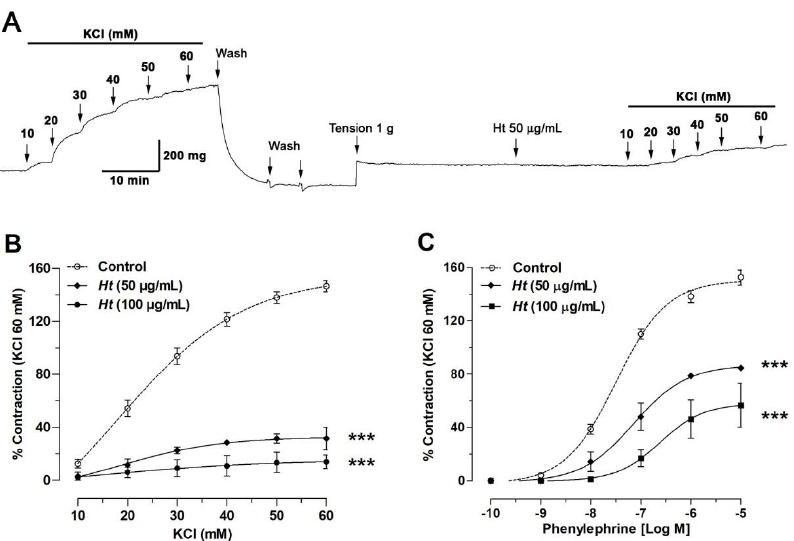
Figure 7. H. taltalense reduces the vascular contractile response in intact aorta. Original record of the vascular effect of H. taltalense in intact rat aorta ( A ). Tissue was contracted with accumulative concentrations of KCl (10–60 mM). Subsequently, a similar protocol was repeated in aortic rings pre-incubated with 50 μg/mL H. taltalense (Ht) for 20 min. Aortic rings were pre-incubated with different concentration of extract Ht (50 and 100 µ g / mL) and accumulative concentrations of KCl ( B ) or phenylephrine ( C ) were added. Data are SEM of 4 independent experiments. *** p < 0.001 vs.